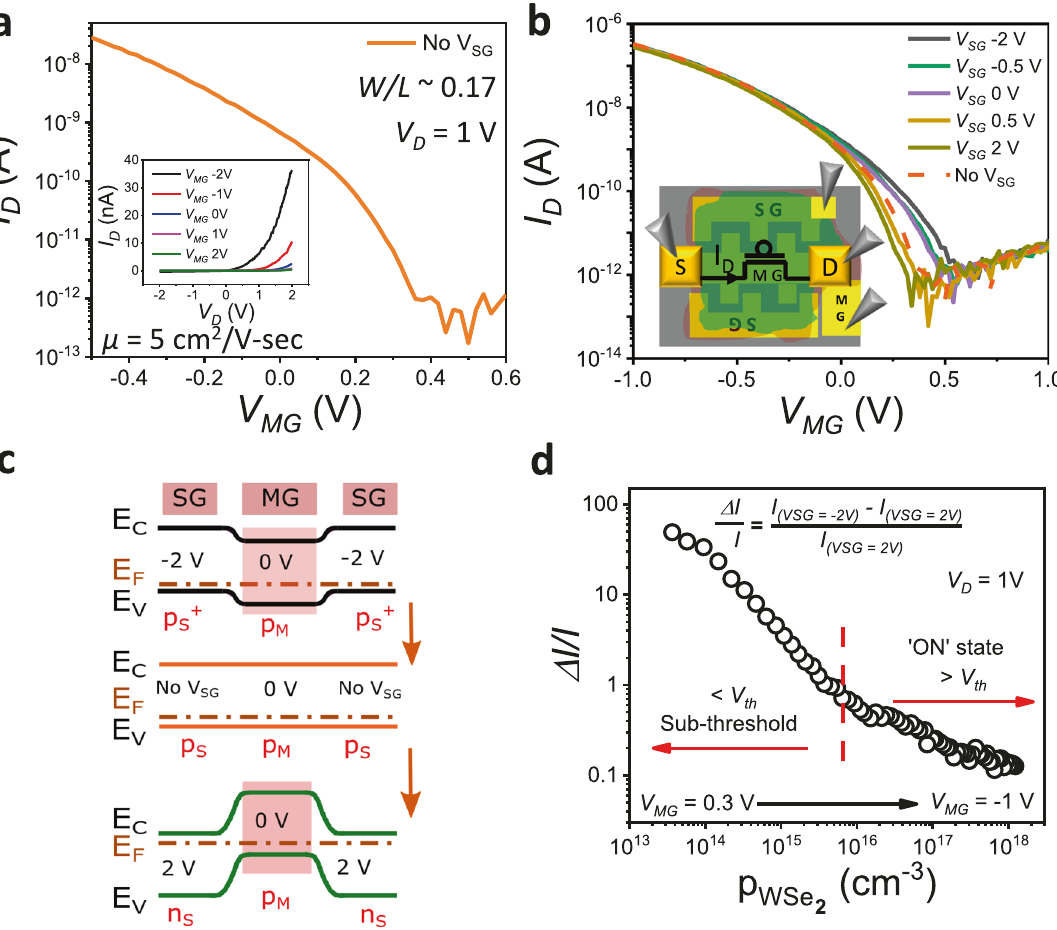
Fig. 2 Device characterization and band alignment under dark. a The transfer characteristic ( I D V MG ) of FET in dark condition shows an on/off current ratio close to 10 5 when V SG is not applied. The inset shows the output characteristics ( I D V D ) without V SG . b Transfer characteristics ( I D V MG ) for V SG